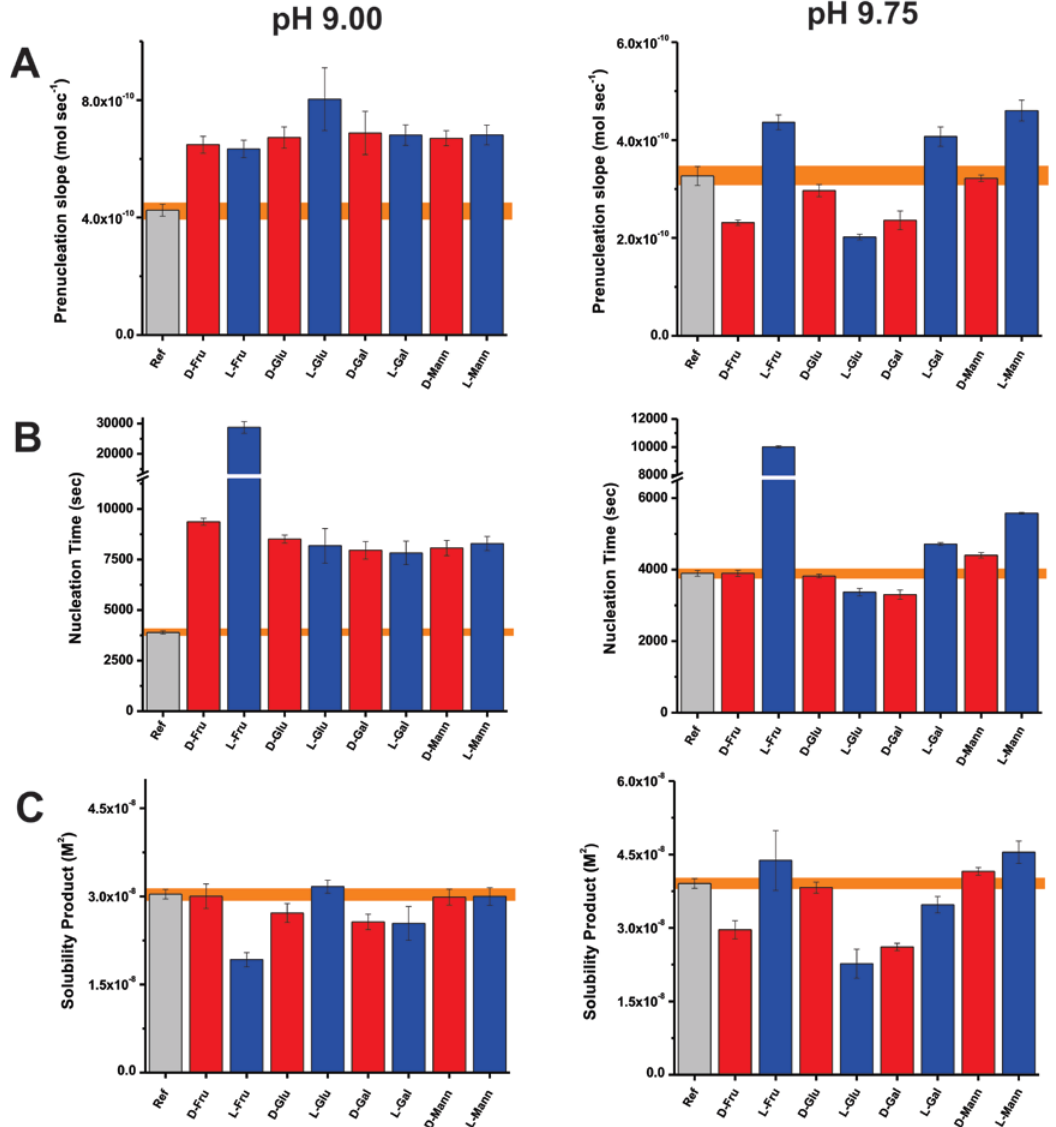
Figure 4. Bar plots representing the early stages of CaCO 3 nucleation in terms of the ( A ) pre-nucleation slope, ( B ) time required for nucleation, and ( C ) solubility of initially nucleated phase at pH 9.0 (left) and 9.75 (right) for additive-containing and reference (Ref) experiments. The acronyms indicate fructose (Fru), glucose (Glu), galactose (Gal), and mannose (Mann) in D (red) and L (blue) forms. Error bars depict ± one standard deviation. Error values for reference experiments are shaded (orange).